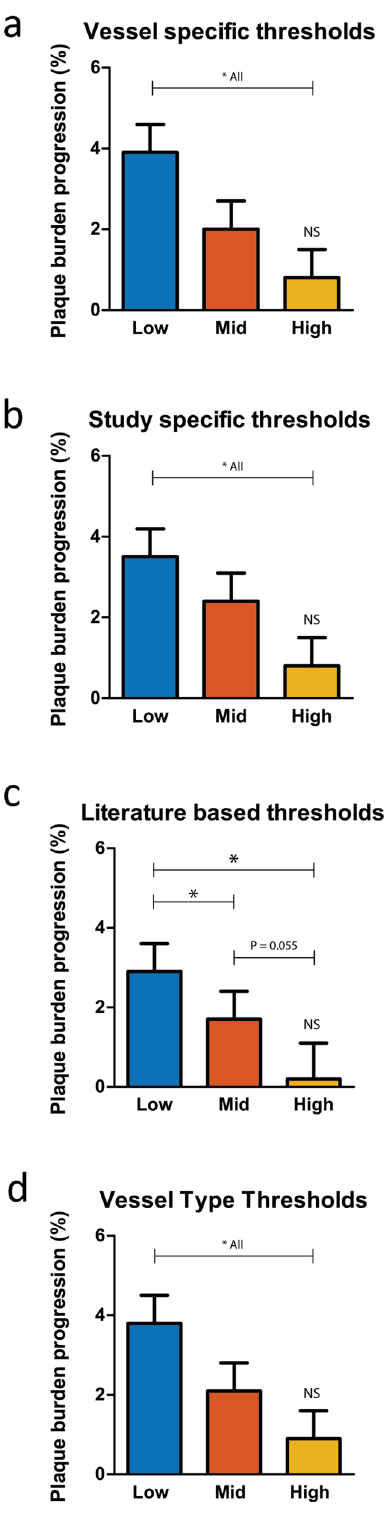
Figure 2. Wall shear stress distribution and plaque progression for the four different thresholding methodologies. * p <